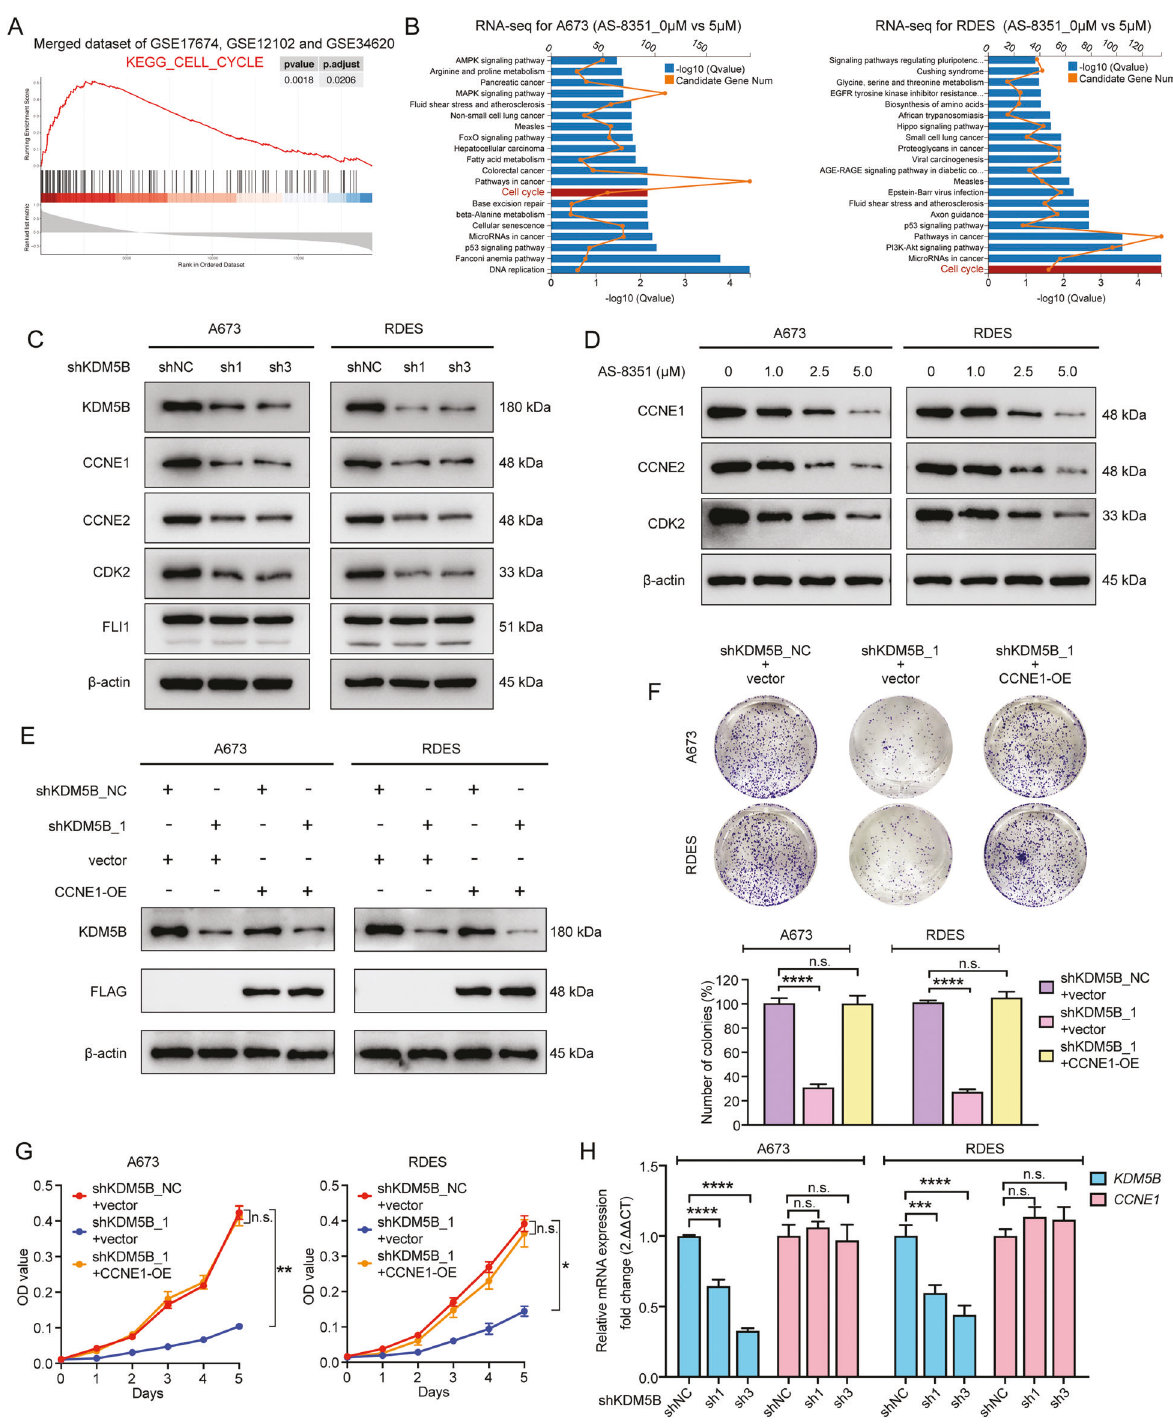
Fig. 4 KDM5B activates cell cycle pathway of Ewing sarcoma cells and promotes protein expression of CCNE1. A Gene Set Enrichment Analysis (GSEA) showing activated cell cycle pathway by KDM5B in a merged dataset of GSE17674, GSE12102 and GSE34620. B KEGG enrichment analysis for RNA sequencing in A673 and RDES cells after vehicle or AS-8351 treatment. C Western blot analysis showing the expression of the key molecules of G1/S phase transition, CCNE1, CCNE2 and CDK2, and FLI1 in A673 and RDES cells after shKDM5B treatment. D Western blot analysis showing the expression of CCNE1, CCNE2 and CDK2, in A673 and RDES cells after AS-8351 treatment. E Western blot analysis of the protein expression in shKDM5B Ewing sarcoma cells treated with or without CCNE1-overexpression. F Up panel: Representative images of colony formation assays in shKDM5B Ewing sarcoma cells treated with or without CCNE1-overexpression. Down panel: Histogram of three biological independent experiments of colony formation assays. G Growth curves of shKDM5B Ewing sarcoma cells A673 and RDES treated with or without CCNE1-overexpression. H Relative mRNA expression of CCNE1 in shKDM5B Ewing sarcoma cells. Error bars in F , G , H indicate standard deviation of three biological independent experiments. P values in F , H are determined by two ‐ tailed unpaired Student ’ s t test. P values in G are determined by two ‐ way ANOVA test. *Above the bars indicates signi fi cant difference; * P < 0.05, ** P < 0.01, *** P < 0.001, **** P < 0.0001; n.s. represents no signi fi cance. Cell Death and Disease (2022)